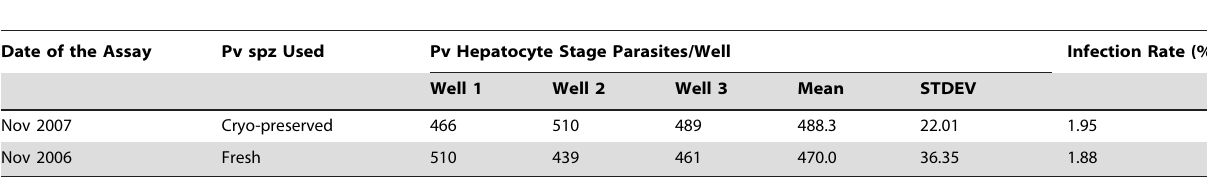
Table 2. No change in infectivity after cryopreservation of Pv